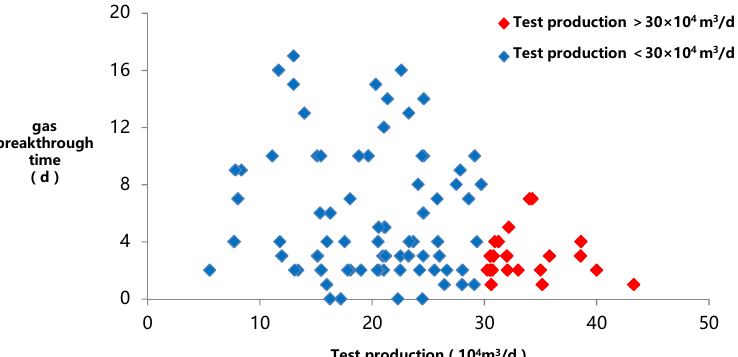
Figure 9. Schematic diagram of relationship between gas breakthrough time and test production of shale gas wells.